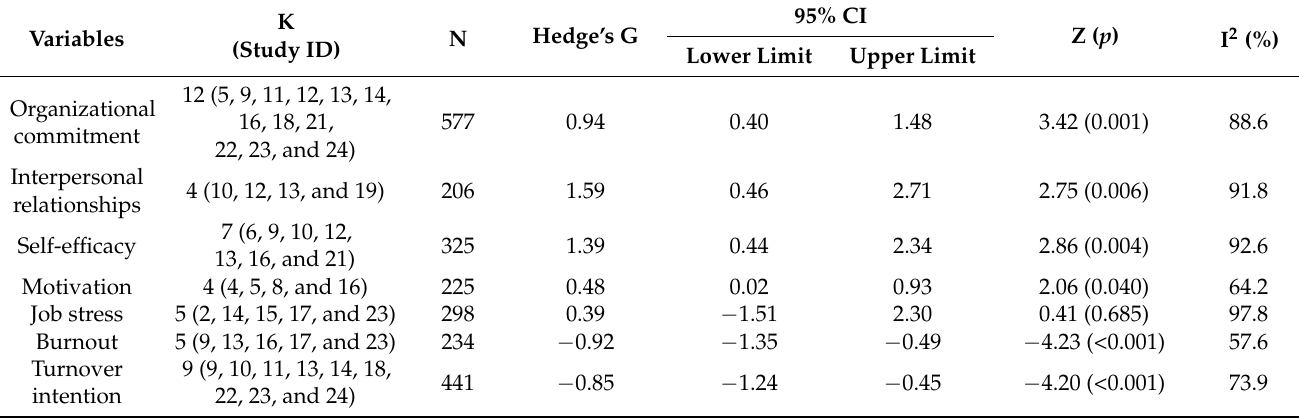
Table 7. The effect of nurse support program on organizational